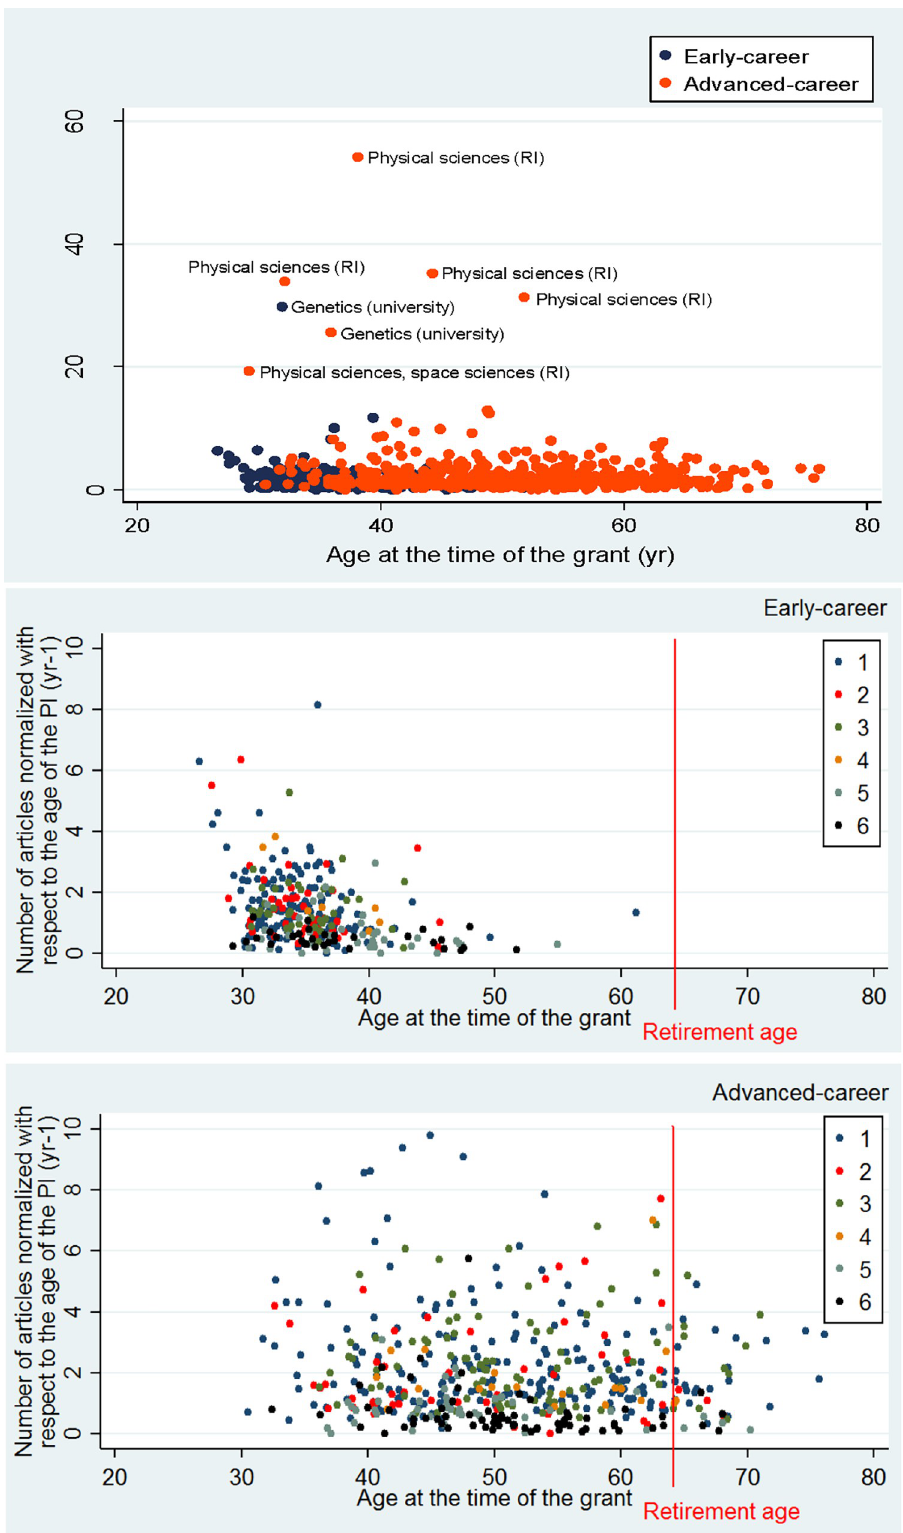
Fig 9. The relationship between the normalized number of peer-reviewed articles and the age of PI at the time of the grant for different grant types across all grants awarded by the Estonian Research Council between